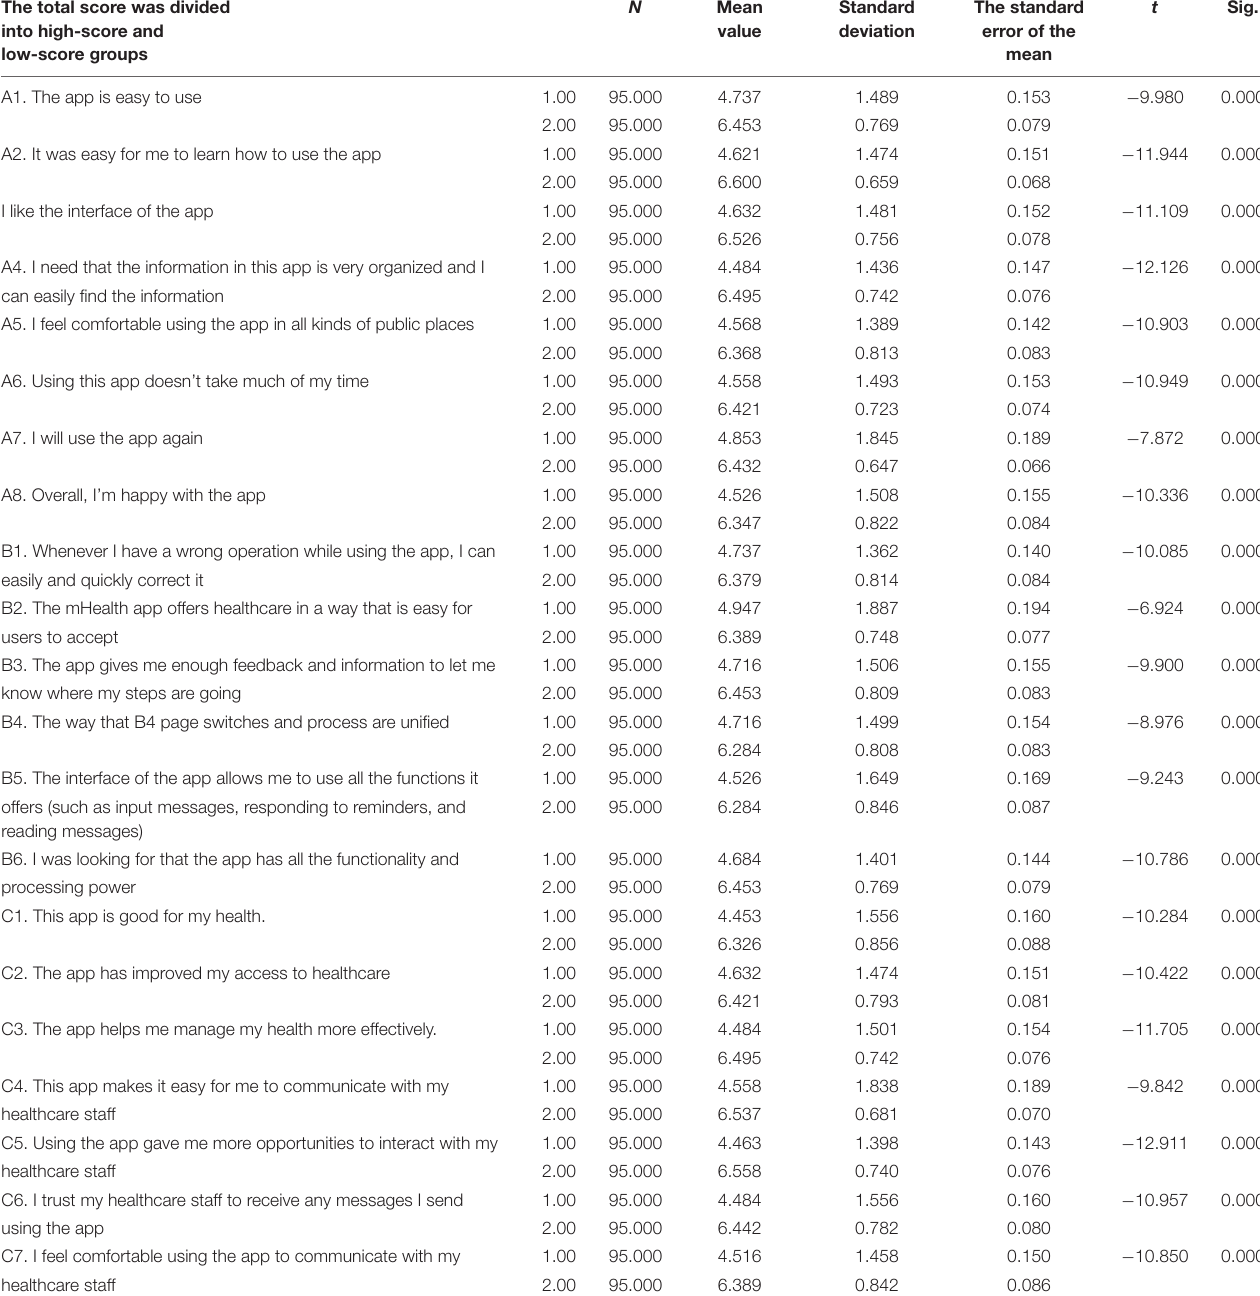
TABLE 2 | Item analysis (standalone-samples t